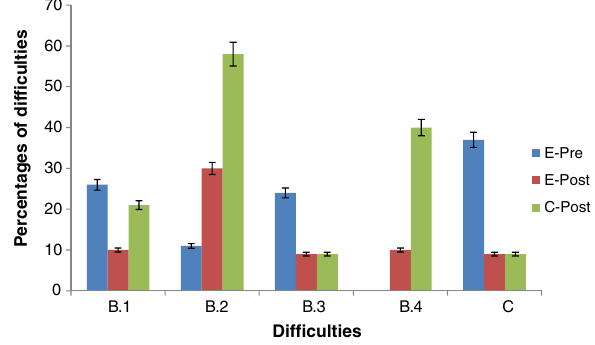
FIG. 2. The average percentage of students expressing each of the incorrect answer categories. For example, difficulty B.1 is relevant to all five questions and the percentage of students expressing this difficulty averaged over all five questions is shown. Ideally, all the bars would be at 0% after instruction, indicating that students expressed none of the